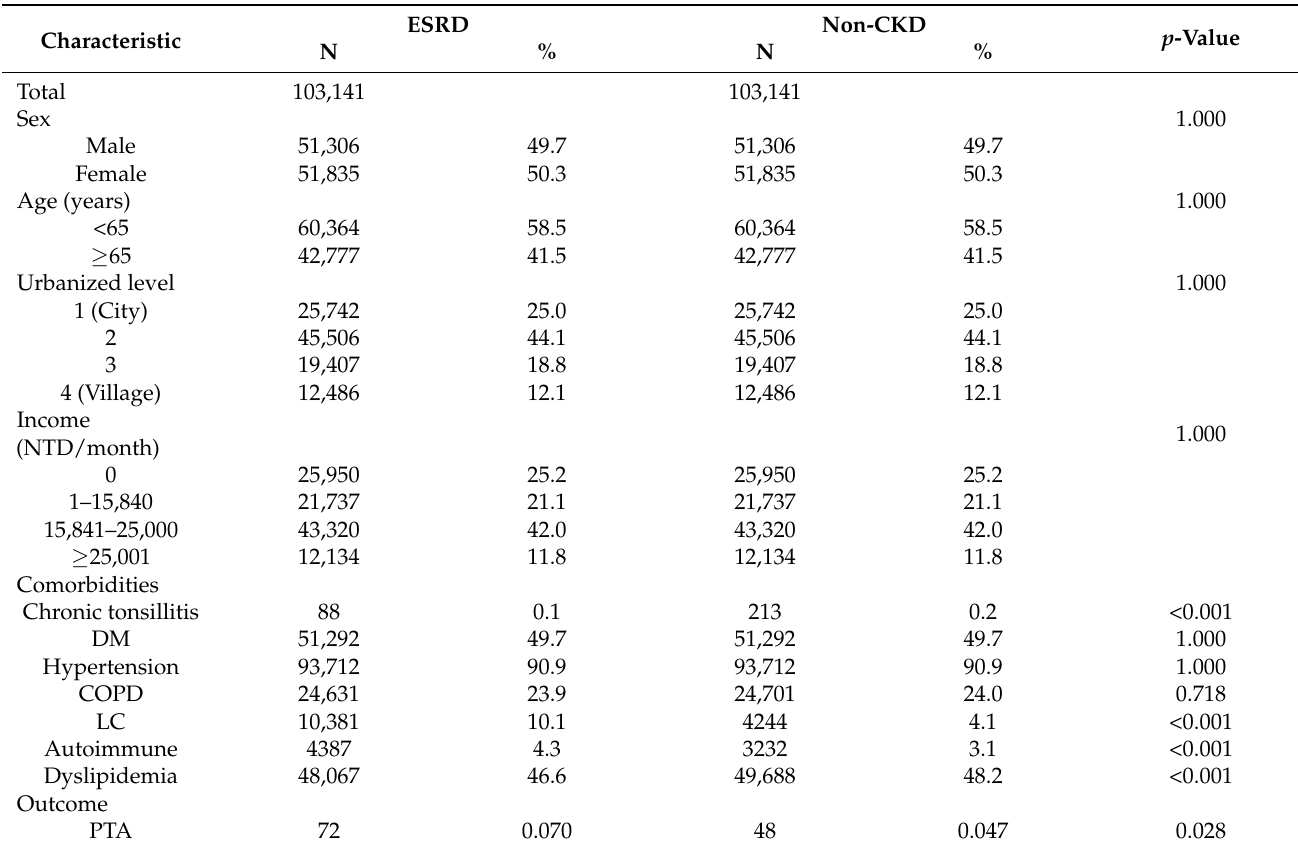
Table 1. Demographic and clinical